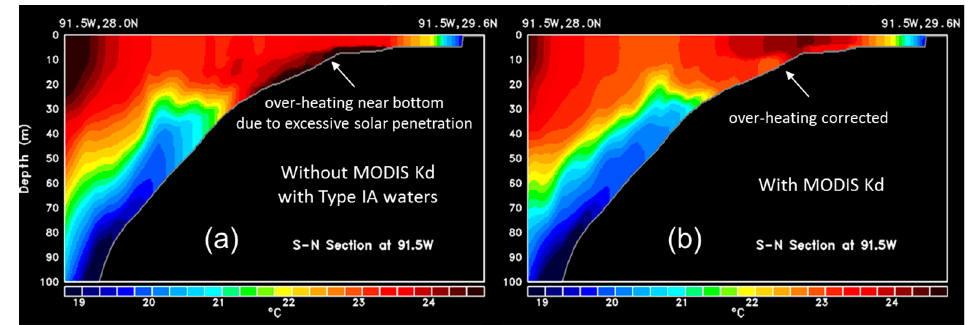
Figure 7. Effect of including satellite diffuse attenuation coefficient (Kd) on thermal structure. Temperature north-south cross-section (right to left) at 91.5°W for May 2008 for ( a ) reference run (solar attenuation parameterized as Jerlov Type 1A oligotrophic water); and for ( b ) test run (solar attenuation determined from satellite Kd).